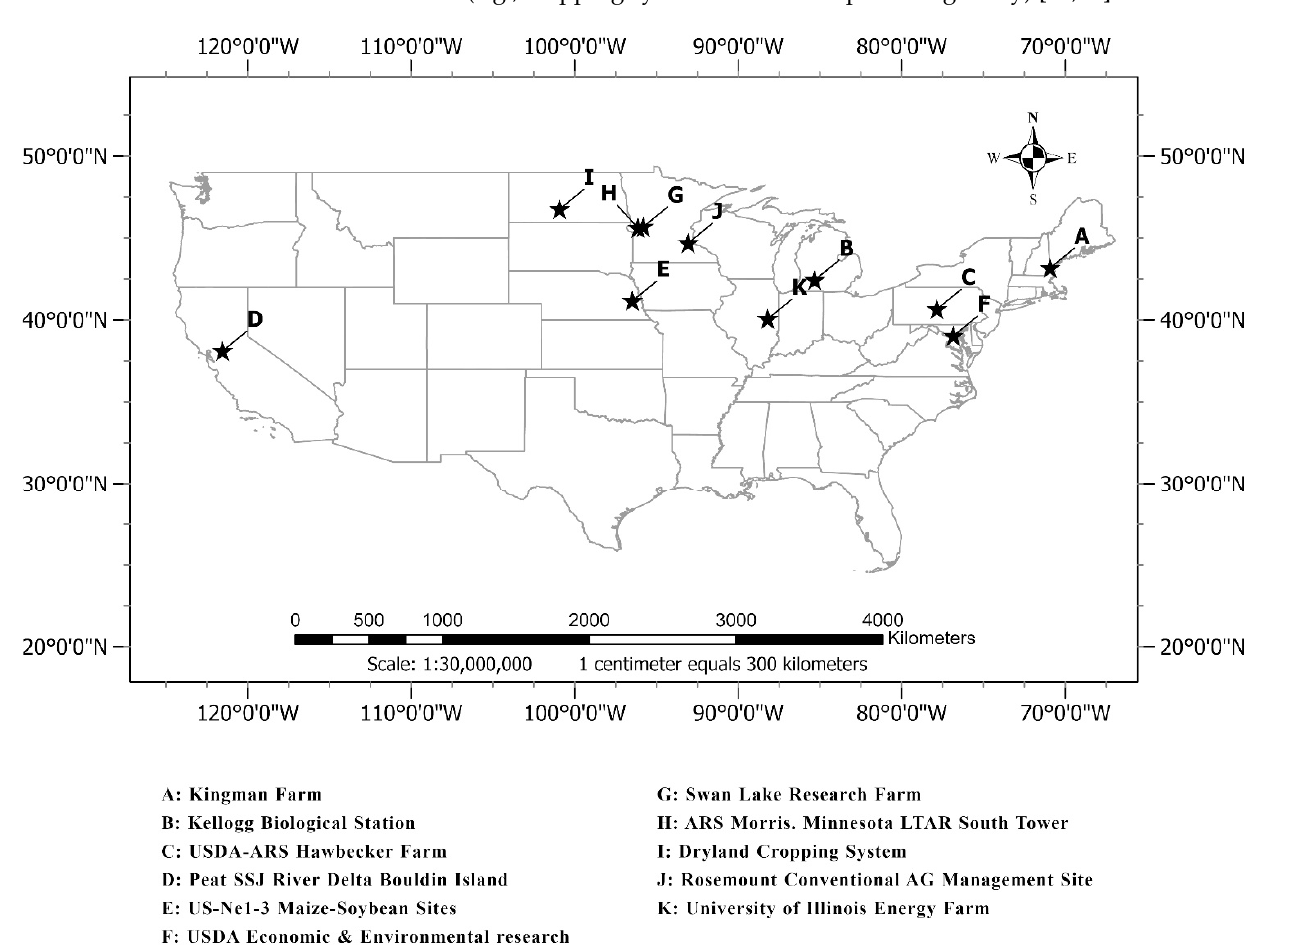
Figure 1. The geographic locations of the study